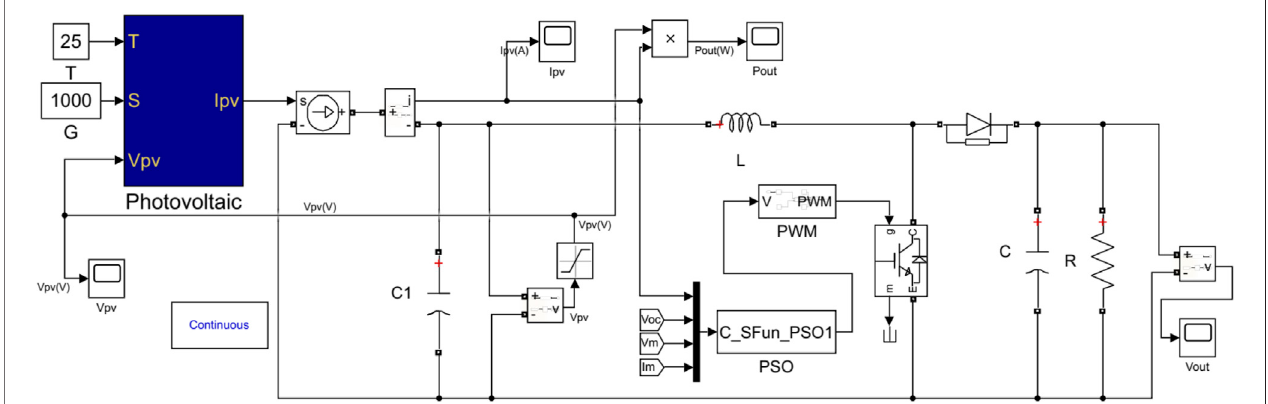
FIGURE 5 | MPPT control system simulation diagram.